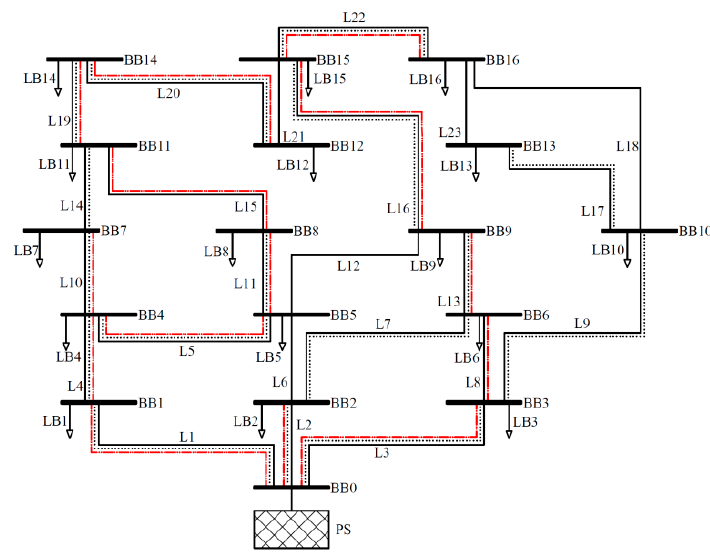
Figure 6. Power system benchmark topology (solid line) with simulation results for p = 1 (dotted line) and for p = 0.95 (red dash-dotted line). Table 1. 20 kV power system model’s loads.